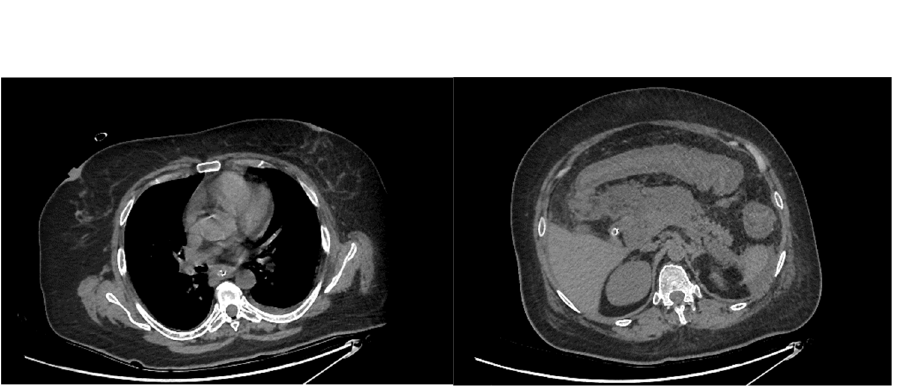
Figure 1. CT revealed minimal pleural effusion and confirmed the presence of peripancreatic necrosis and moderate ascites.